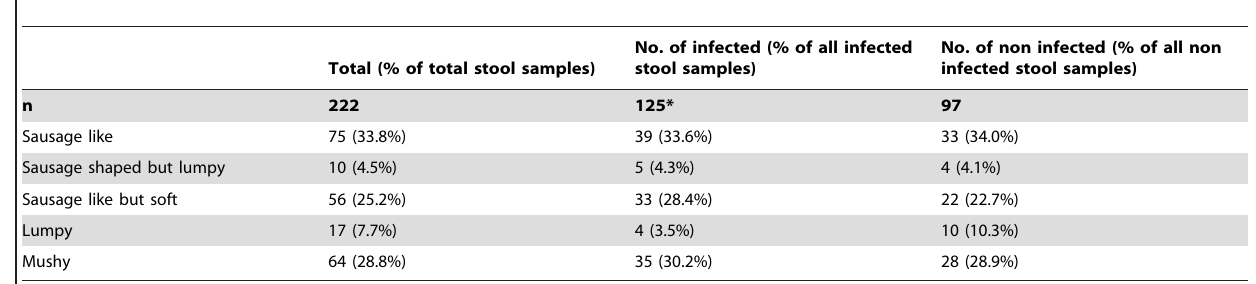
Table 2. Number of stool samples in each consistency category by infection status (any helminth infection), from 222 study participants from Azaguie´, Coˆte d’Ivoire, in 2010.